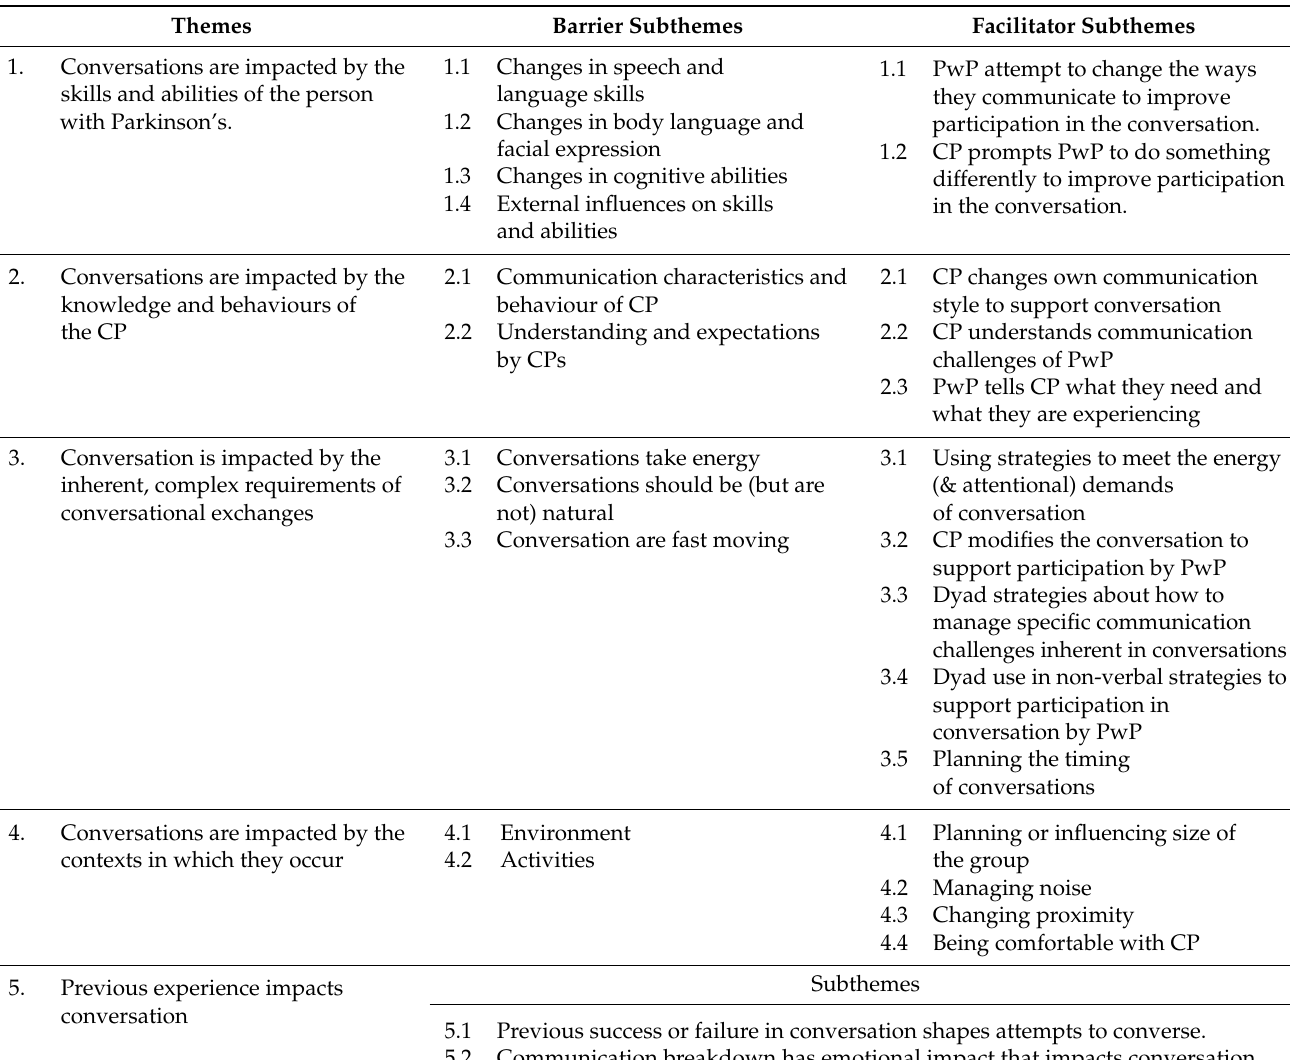
Table 2. Themes and